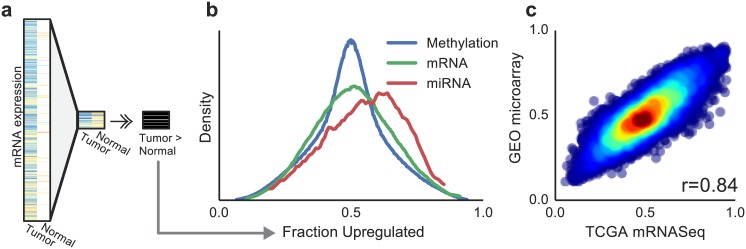
Description of the f
up statistic.(a) Schematic of the calculation of fraction upregulated (f
up) for a single gene expression profile across the TCGA cohort. Data are filtered to include only matched samples, the magnitudes of paired tumor/normal samples are compared, and a fraction of how often the gene is upregulated is recorded. (b) Density of f
up statistic across genome-wide mRNA, miRNA, and methylation measurements. (c) Comparison of mRNA f
up statistic calculated from TCGA mRNASeq measurements versus microarray measurements downloaded from GEO.